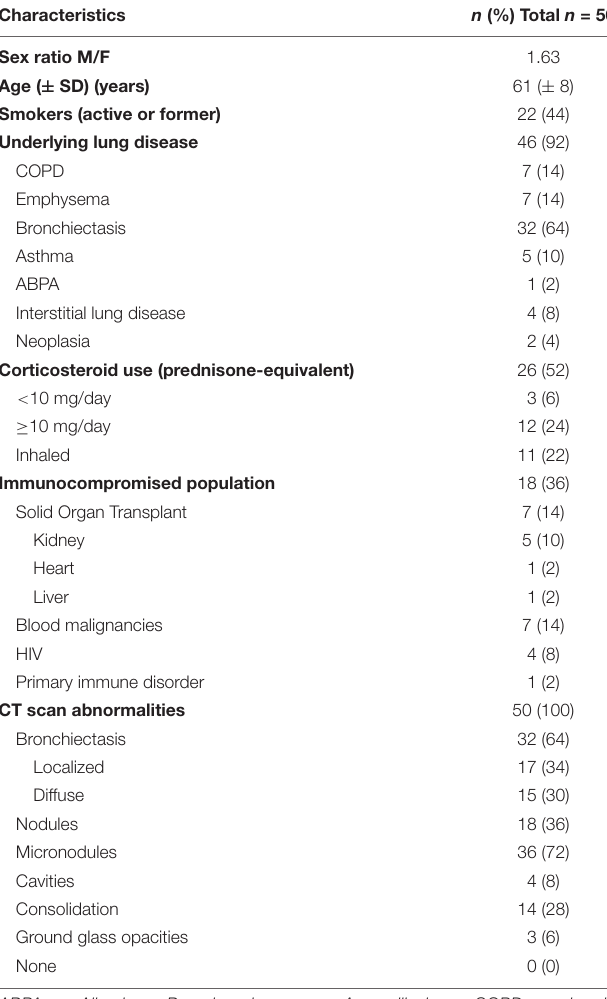
TABLE 1 | Clinical and radiological characteristics of 50 patients with concomitant detection of Aspergillus sp. and Mycobacterium sp. in respiratory samples.